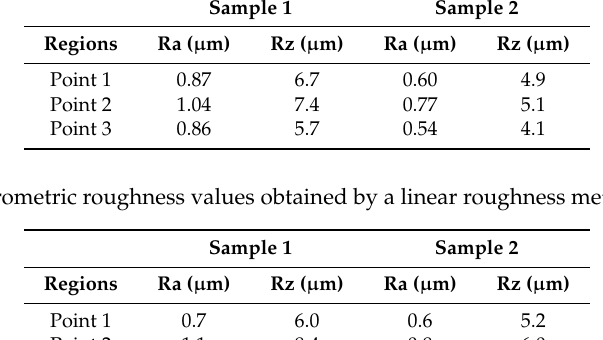
Table 9. Micrometric roughness values obtained by linear roughness meter in June 2019.